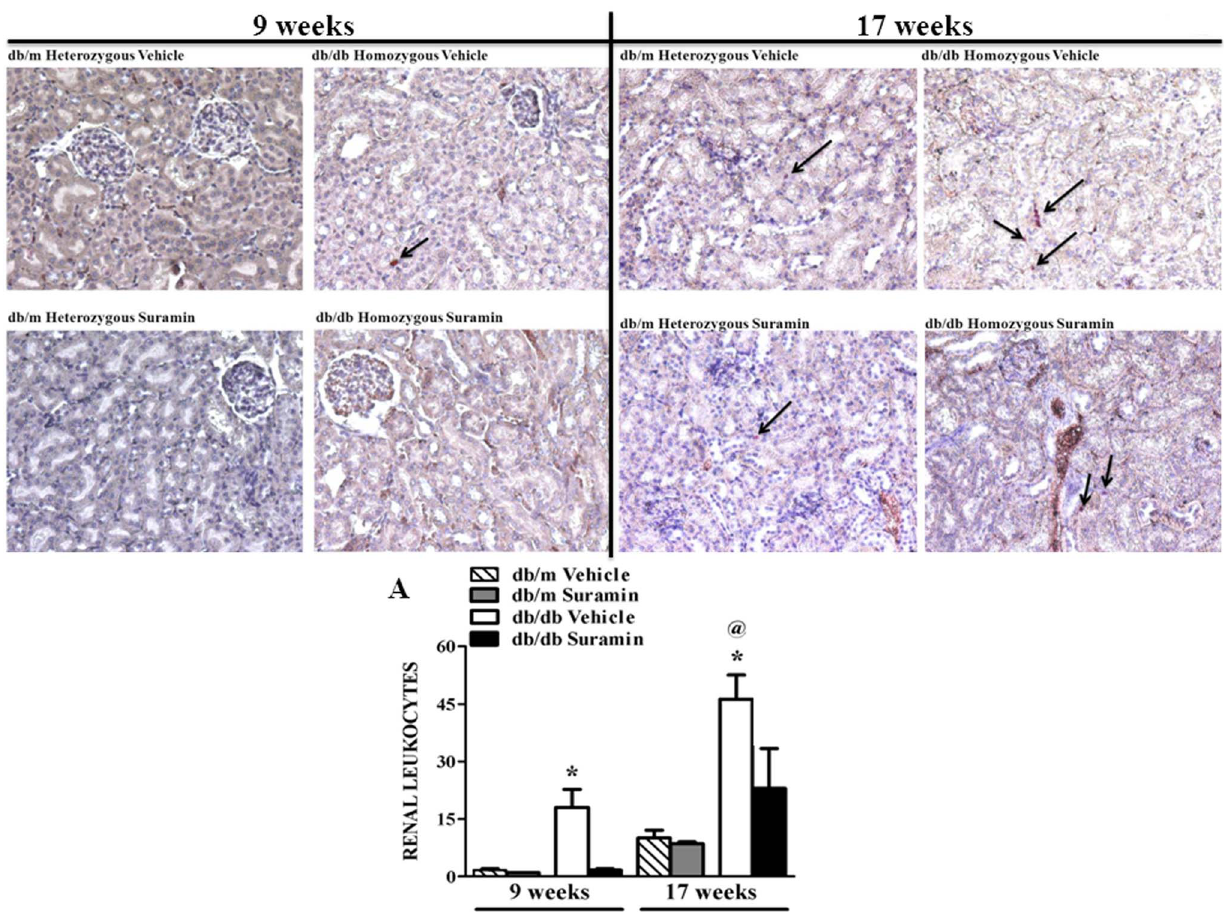
Figure 3. Effect of delayed administration of suramin on renal leukocyte infiltration in 9/17 week db/db mice. Mice were treated as described in Figure 1. Representative photomicrographs of neutrophil and monocyte staining assessed by formation of stable pinkish-red colored (arrows) complex of free naphthol and diazonium salts following incubation of kidney sections from 9/17 week non-diabetic and diabetic mice 6 suramin intervention, respectively. All fields were chosen from the cortical regions of the kidney sections. Original magnification, 200 X. A . Quantitative analysis of renal leukocyte infiltration assessed by number of pink colored dots in a total of 25 fields in the cortical region of kidney sections. Data are expressed as mean 6 SE (n=4). * Significantly different from respective non-diabetic db/m mice ( p # 0.05). @ Significantly different from vehicle-treated 9 week diabetic db/db mice ( p # 0.05).